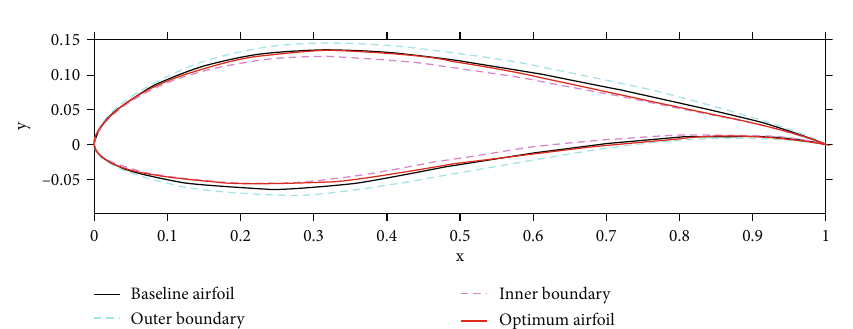
Figure 10: Comparison of airfoil pro fi le before and after